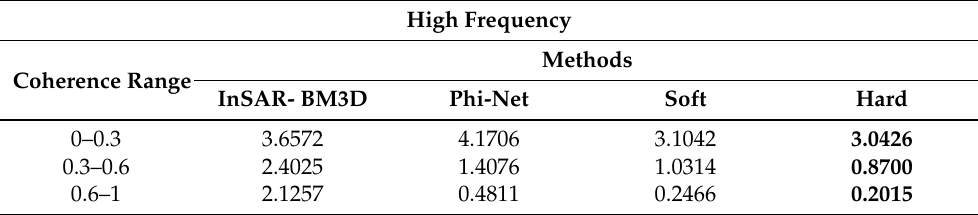
Table 5. Quantitative index Equation (36) of the compared methods on simulated high-frequency fringes.